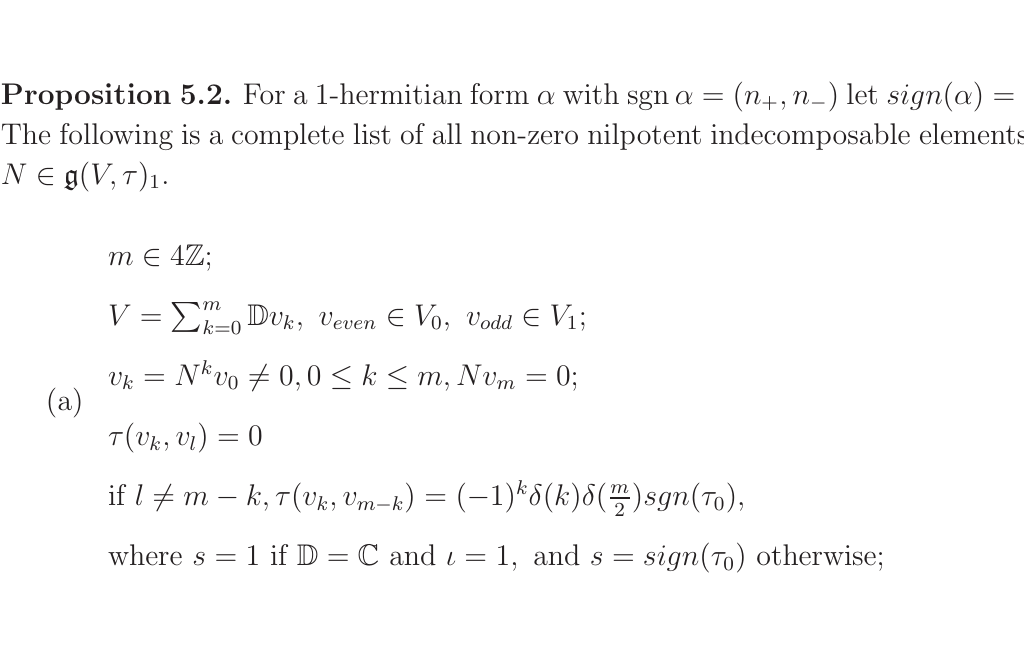
Table 2 The list of Z / 2 Z -graded (1 , m )-admissible